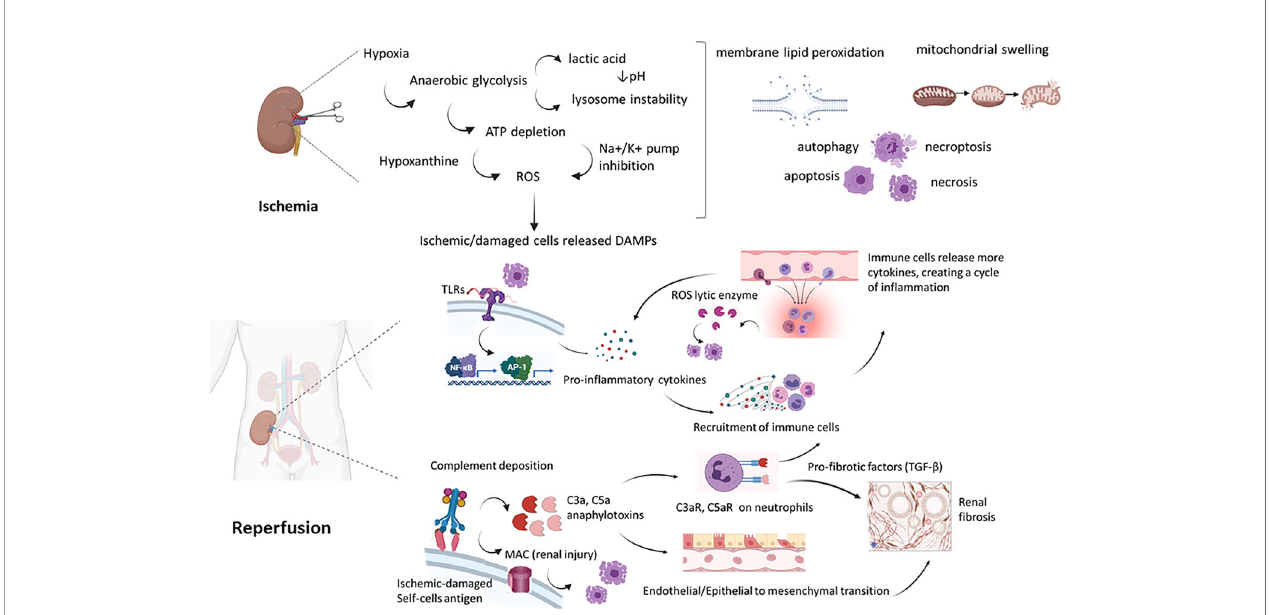
FIGURE 2 | Molecular mechanisms of renal IRI. During ischemia, the lack of oxygen and substrates led to inhibition of oxidative phosphorylation, thereby to ATP depletion. From a side this led to an anaerobic lactic acid-associated glycolysis, with pH decrease and lysosome lytic enzyme release. From the other, the blockade of pump Na/K activated proteases and phospholipases, leading to increased Ca++ level. Furthermore, ATP produced in aerobic tissues is lysed into AMP, adenosine, inosine and hypoxanthine. Hypoxanthine is metabolized by xanthine oxidase in ischemic tissues, in a reaction that uses molecular oxygen (O 2 ) and release toxic ROS as intermediate products. During reperfusion, DAMP released by ischemic damaged kidney cells are recognized by PRR as TLR on immune cells but also on endothelial cells leading to increased gene expression of pro-in fl ammatory cytokines that recruited and activated leucocytes. These cells released more cytokines, in an ampli fi cation loop culminating into ROS release by macrophages and neutrophils, interstitial in fi ltrates and kidney damage. Ischemic damaged cells can activate complement system (by Collectin-11, MBL) that result in anaphylotoxins C3a and C5a generation and MAC-mediated cell injury. These acute processes have been linked to early renal fi brosis development by the process of EndMT, EMT and PMT (Endothelial to mesenchymal transition, Epithelial to mesenchymal transition and Pericytes to mesenchymal transition). TLR, Toll Like receptor; MAC, membrane associated complex; DAMP, Damage-associated molecular patterns; PRR, Pattern Recognition Receptors; ROS, reactive oxygen